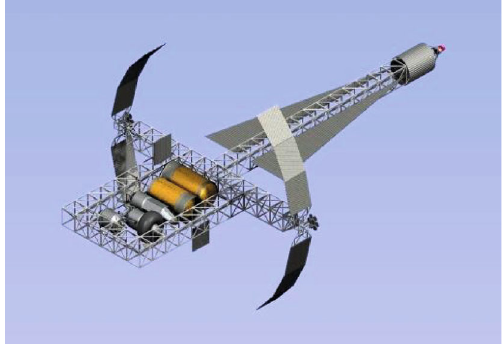
Figure 1: BNTR thruster [12].